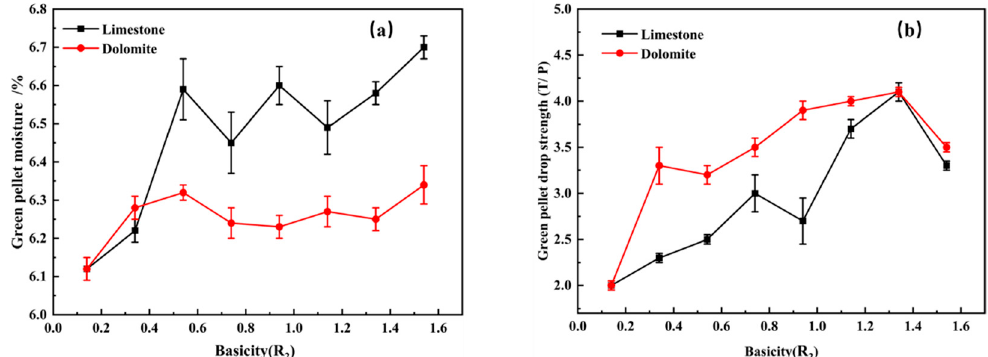
Figure 4. Effect of basicity and flux type on the moisture and drop strength of the green pellets. ( a ) Effect of basicity and flux type on the moisture of the green pellets; ( b ) Effect of basicity and flux type on drop strength of the green pellets.